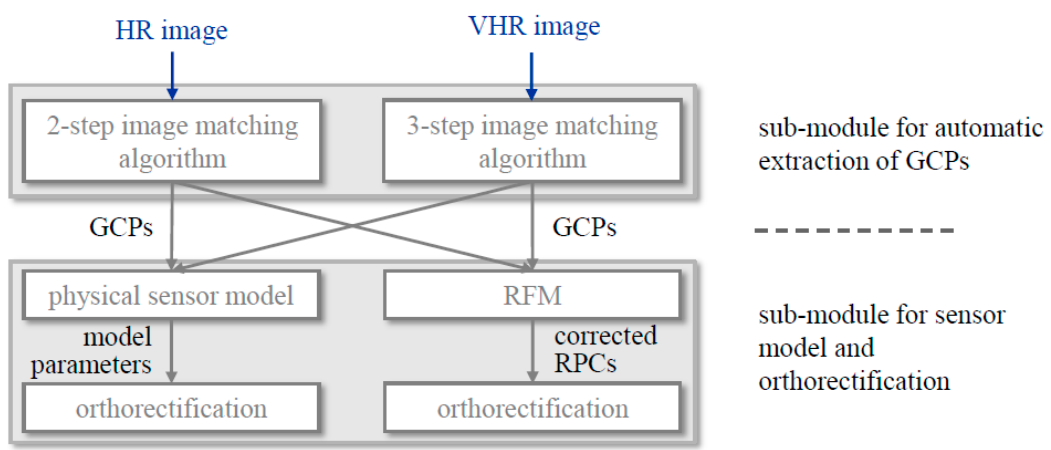
Figure 3. Workflow of the geometric corrections module within the STORM processing chain. High resolution (HR) and very high resolution (VHR) images are processed differently. Each image goes through three processing steps; due to organizational reasons the latter two are joined into one sub-module.